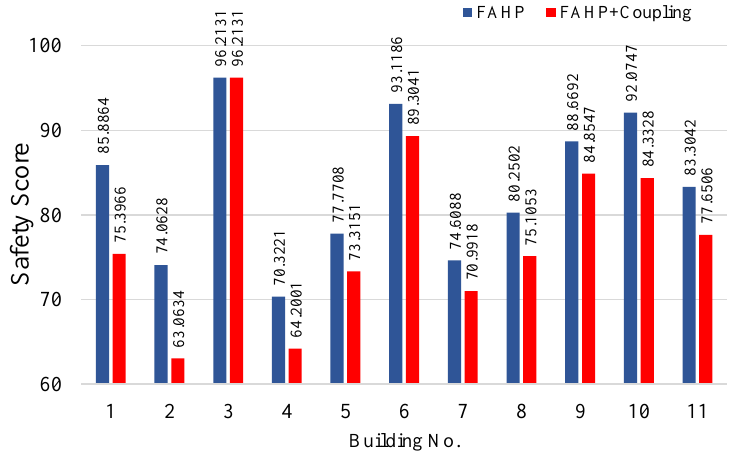
Figure 10. The safety score results obtained by the FAHP with and without coupling revision.